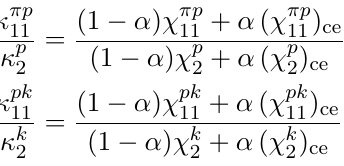
=(cid:20) p and 11 2